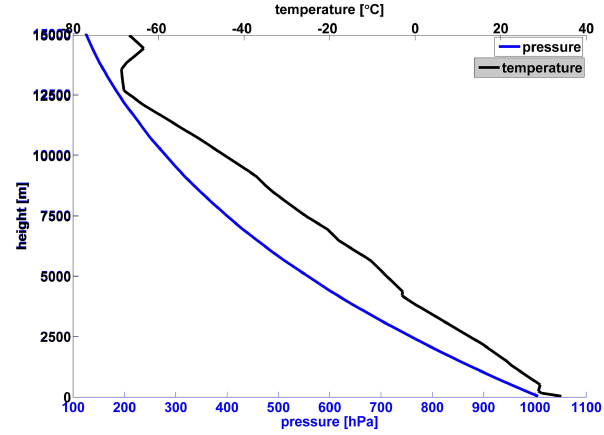
Fig. 12. The rasiosonde measured atmospheric temperature and pressure profile at the time of the FOV